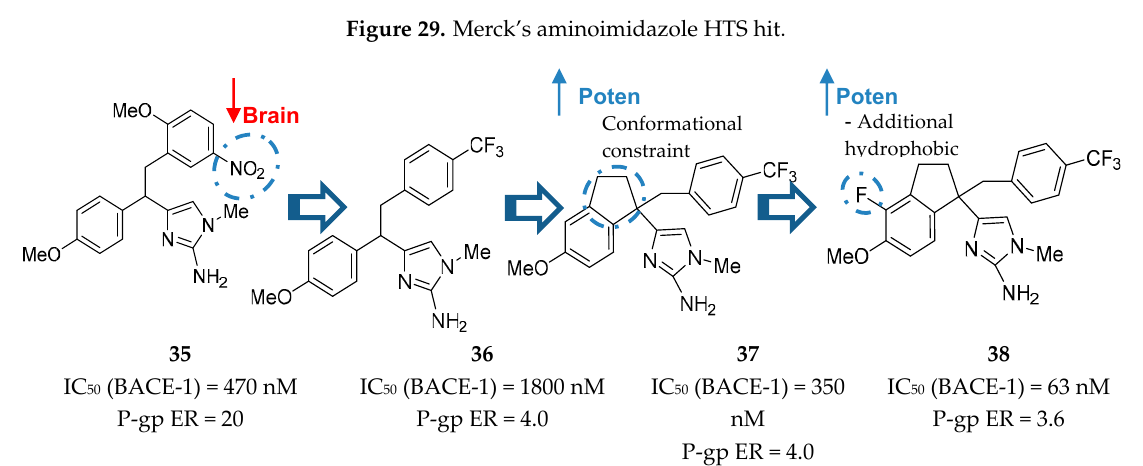
Figure 30. Merck’s aminoimidazole-based inhibitors.